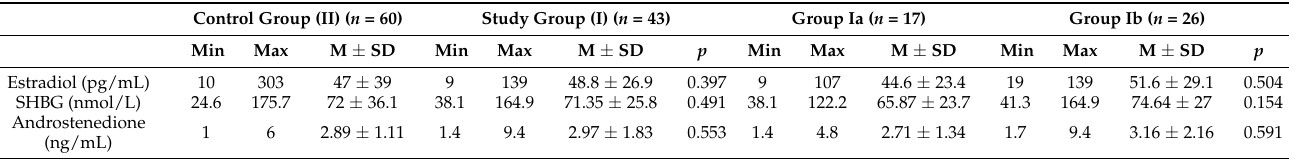
Table 2. The concentrations of the estradiol, SHBG, and androstenedione in individual